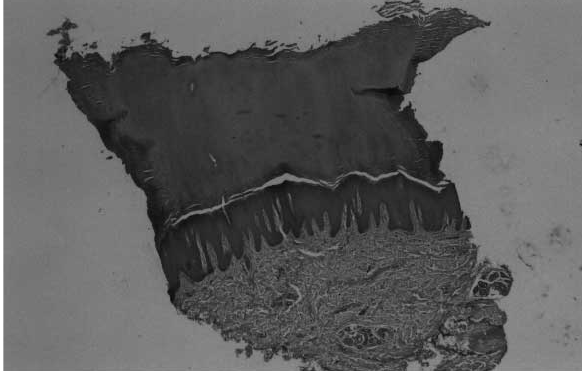
Figure 3 - Skin biopsy (HE) of palmar area showing